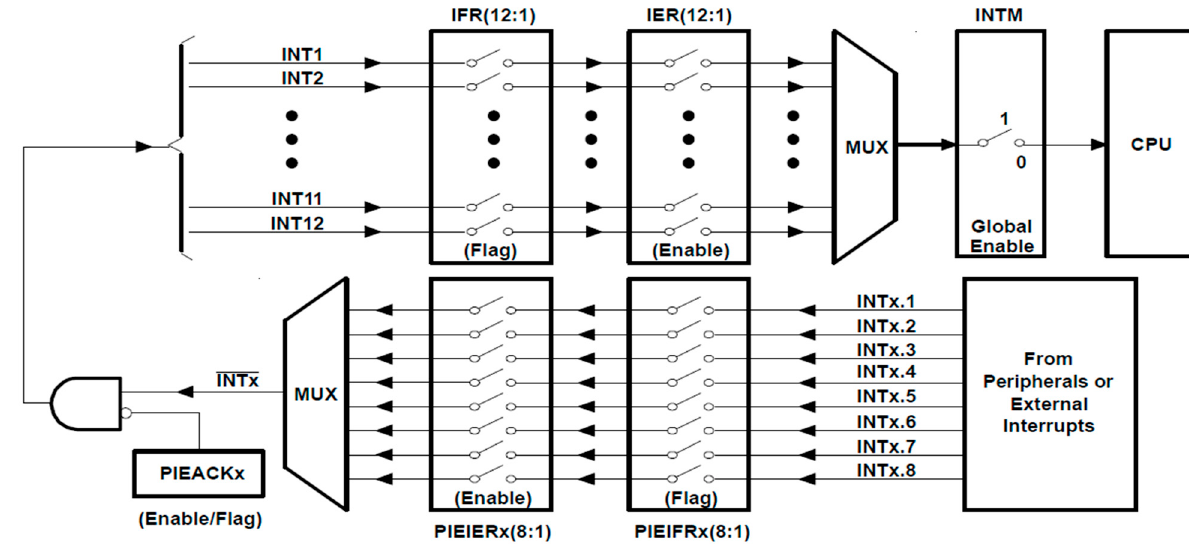
Figure 9. Interrupt multiplexing diagram of the Peripheral Interrupt Expansion (PIE) module.